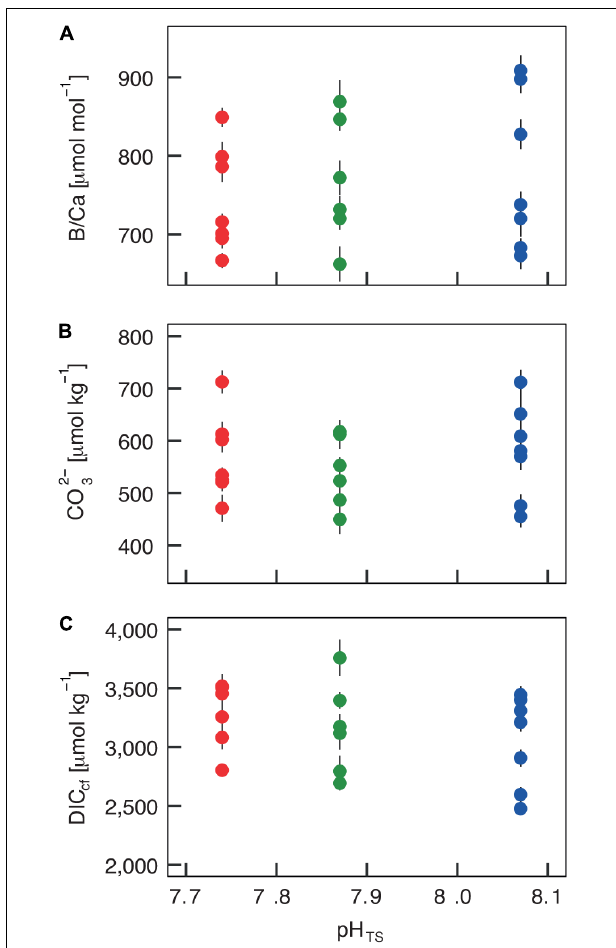
FIGURE 3 | Internal carbonate ion concentration ([CO 32 - ]) and dissolved inorganic carbon concentration (DIC cf ) at the calcification site derived from the skeletal B/Ca concentration in Balanophyllia europae a along the pH TS gradient at Panarea Island, Italy. (A) Coral skeletal B/Ca ratio from naturally different seawater pH (pH in total scale) sites were translated into (B) internal calcifying fluid [CO 32 - ] values and (C) DIC cf . Circles represent values for each individual coral (mean ± SEM). Color denotes the different locations: Site 1 = blue, Site 2 = green, Site 3 = red.